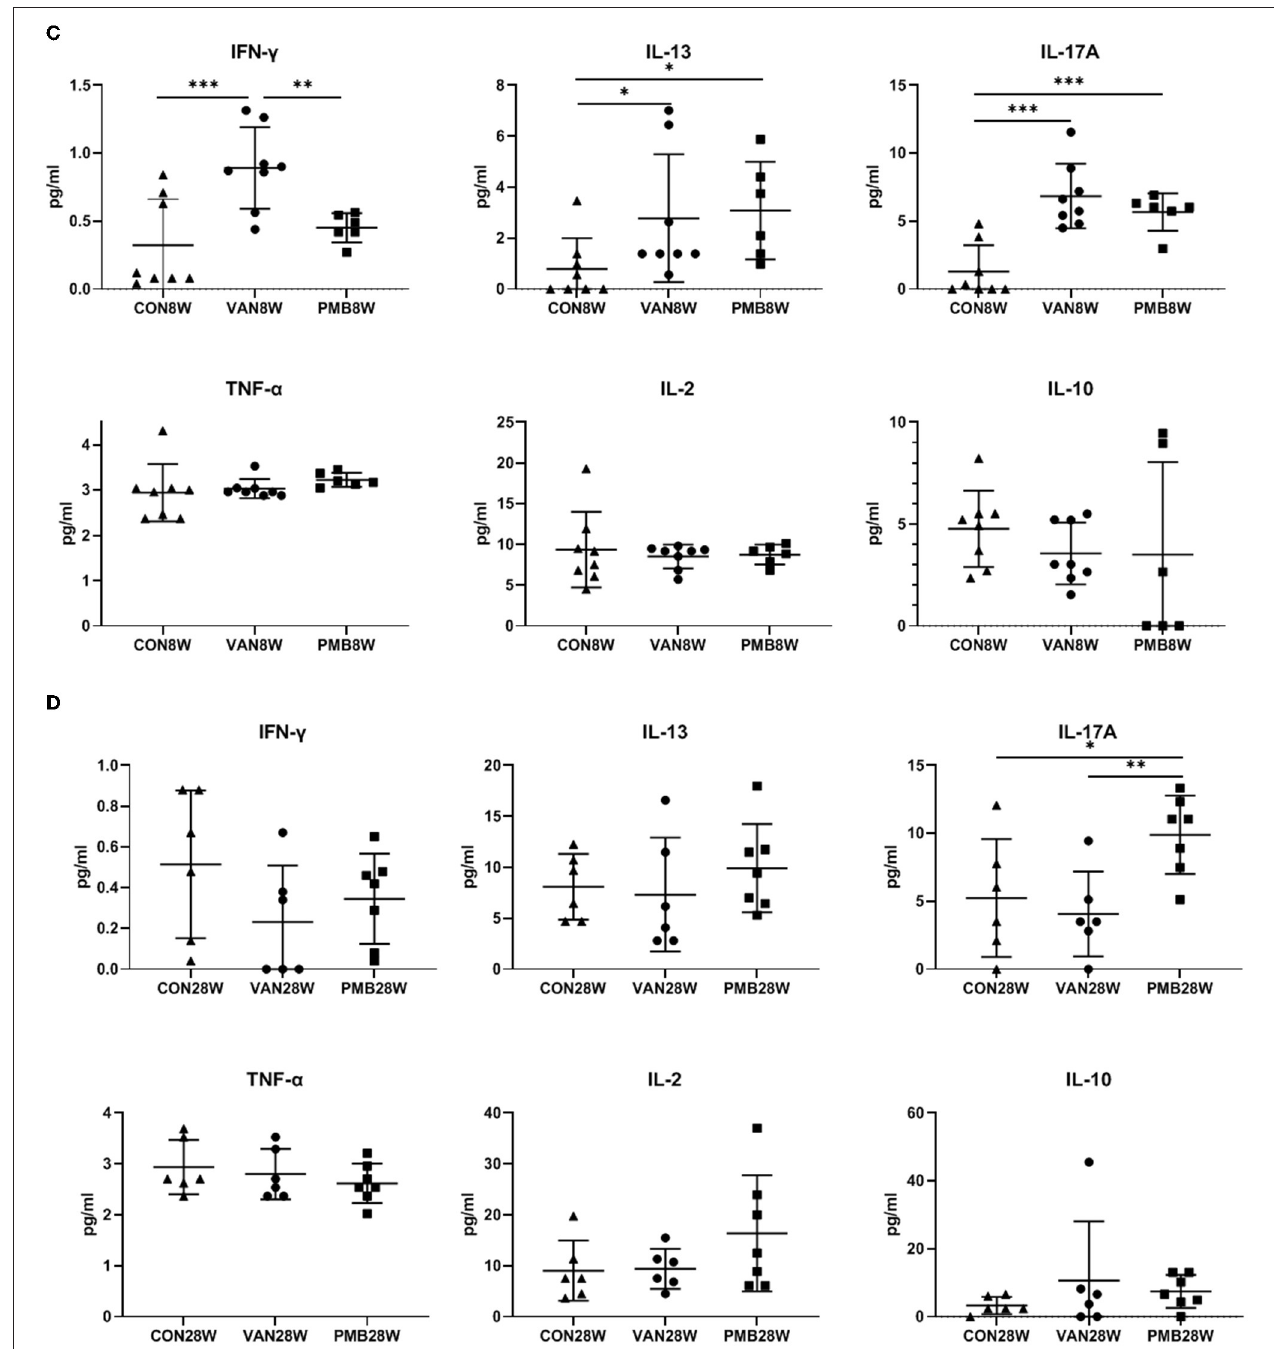
FIGURE 10 | Changes in levels of serum cytokines after vancomycin treatment for 8 and 28 weeks (A) , polymyxin B treatment for 8 and 28 weeks (B) , vancomycin and polymyxin B treatment for 8 weeks (C) and 28 weeks (D) . Significant differences between the two groups were marked, and *indicates p < 0.05; ** p < 0.01 and *** p <